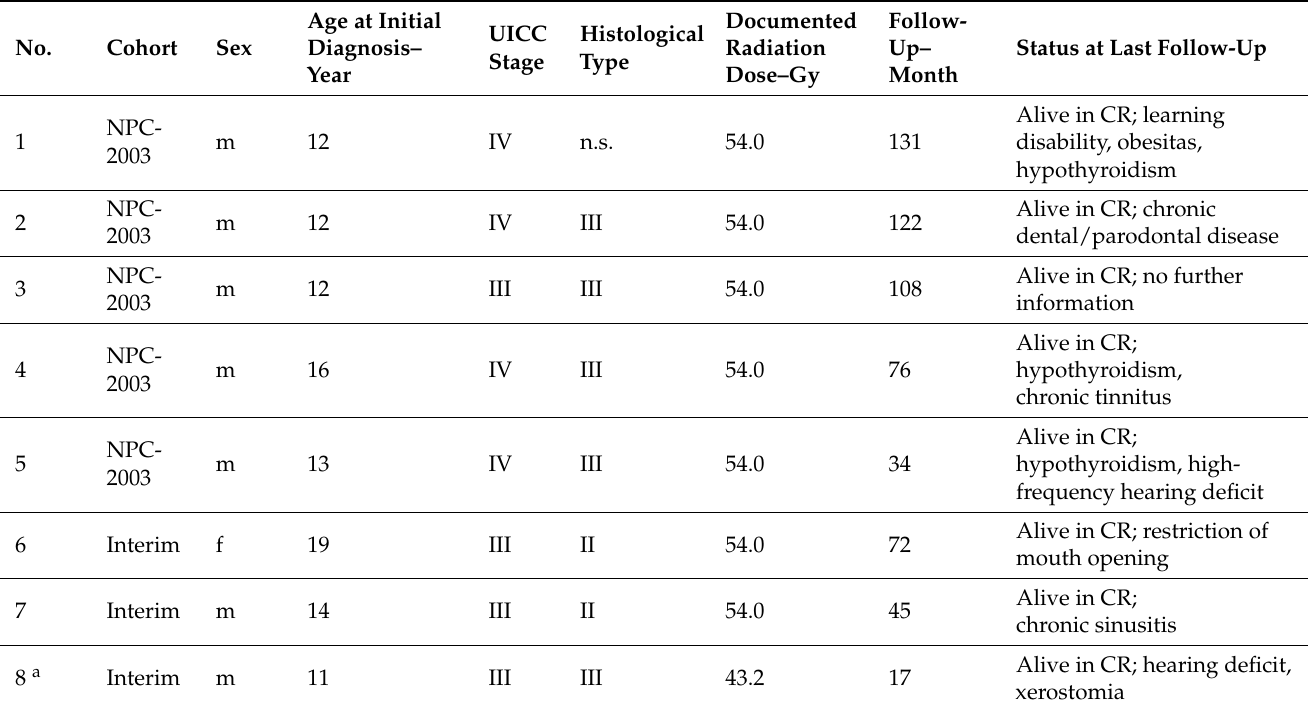
Table 3. Characteristics of patients who received a reduced radiation dose due to CR after induction